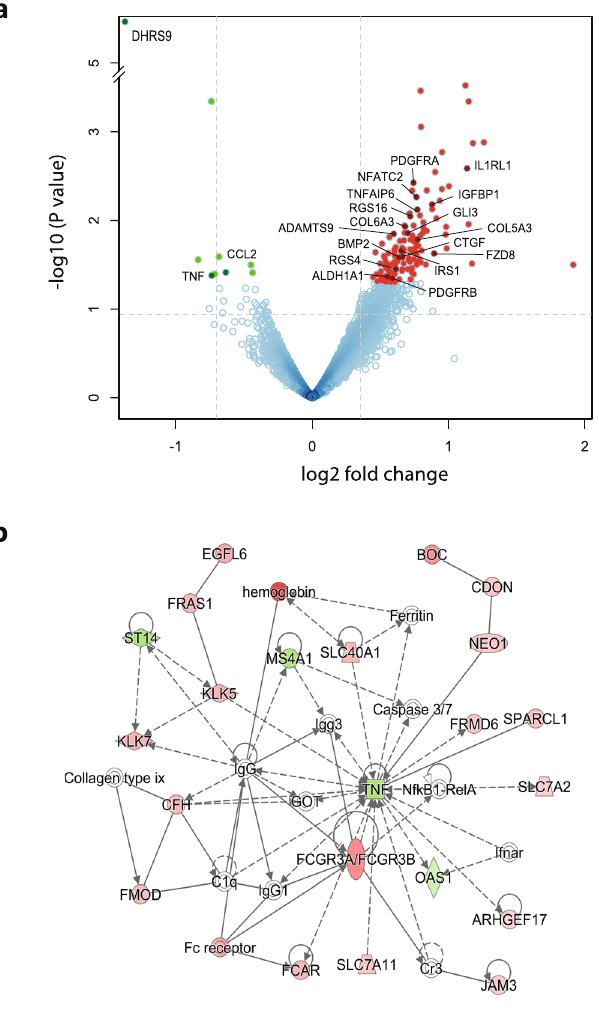
Figure 5. Network analysis of differentially abundant transcripts in peritoneal effluent cells. RNA-seq data was obtained from cells harvested from PET effluent samples in the randomized clinical trial testing the effect of supplemental AlaGln in PDF. ( a ) Volcano plot of abundance ratios and p-values of individual transcripts with and without AlaGln. Log fold-change values of the paired analysis with vs . without AlaGln are plotted against the negative log p value for individual transcripts ( b ). Interaction network generated from differentially expressed genes. Each node represents a gene and edges interaction among genes. The node color indicates up- regulation (red) or down-regulation (green) in the presence of added